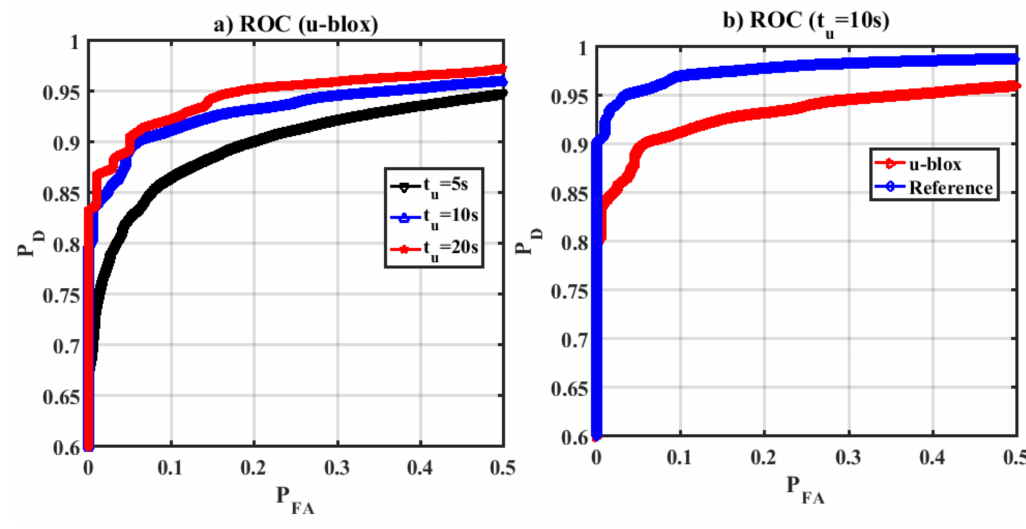
Figure 16. ROC curves ( a ) GPS-based trajectory (u-blox receiver) and different update intervals. Increasing t u improves the detection performance. ( b ) ROC curves for true-reference and GPS trajectories for t u = 10 s. The detection performance is degraded due to GPS measurement